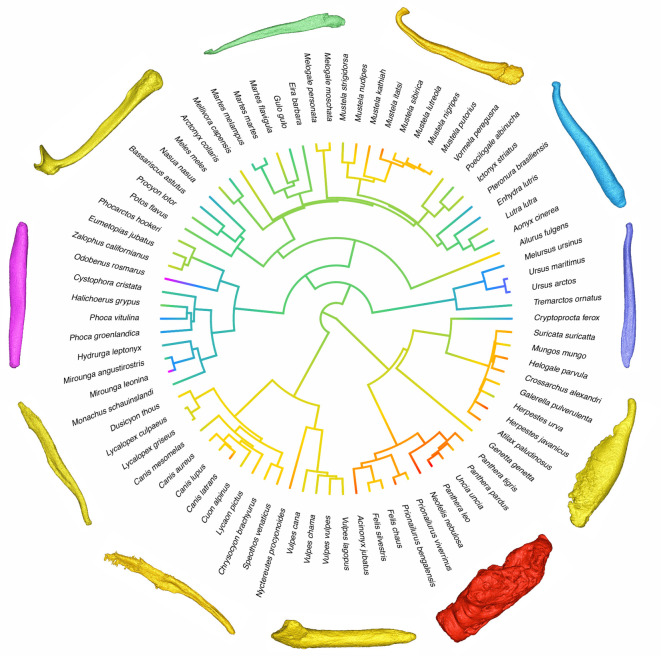
Ancestral state reconstruction of log10 baculum complexity across Carnivora. Consensus phylogeny sourced from 10kTrees project (https://10ktrees.nunn-lab.org/index.html). Trait evolution was reconstructed using the ‘phytools' function ‘fastAnc' and plotted using ‘contMap'. Cool colours = low alpha shape complexity; hot colours = high alpha shape complexity. Dorsal surface of three-dimensional models faces outwards from the tree root, distal tips point in an anti-clockwise direction. Clockwise from top: Mustela lutreola, Pteronura brasiliensis, Ursus maritimus, Mungos mungos, Panthera leo, Felis silvestris, Speothus venaticus, Canis lupus, Mirounga leonina, Mellivora capensis, Eira barbara. Example species for three-dimensional surfaces were selected as being representative of their closely related taxa. (Online version in colour.)